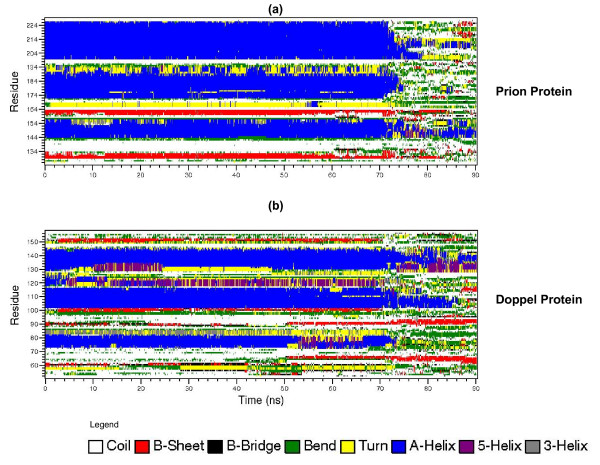
Secondary Structure Evolution. Time evolution of the secondary structures calculated according to the DSSP algorithm of PrP (a) and of Dpl (b) during the simulations. Between 0–50 ns the temperature was 310 K; 50–70 ns 350 K; 70–90 ns 450 K.